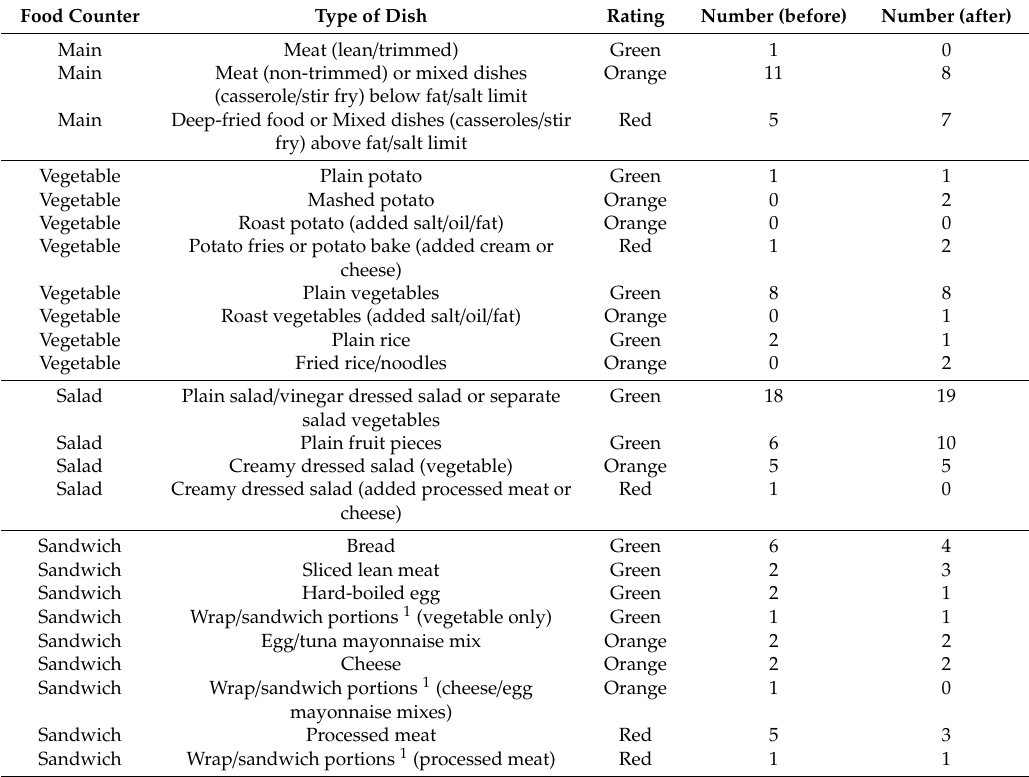
Table A1. Summary of healthfulness classifications of dishes made available at